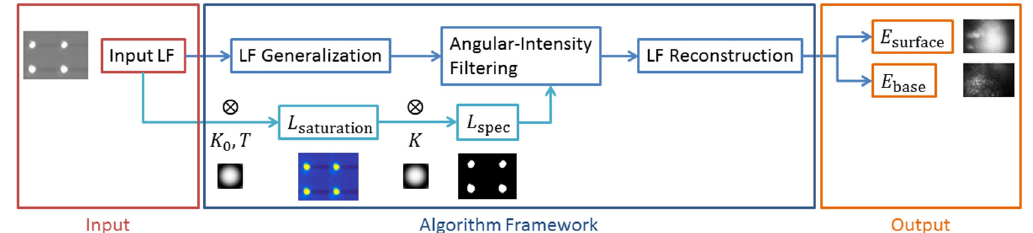
Figure 4. The framework of the AIF algorithm implementation.